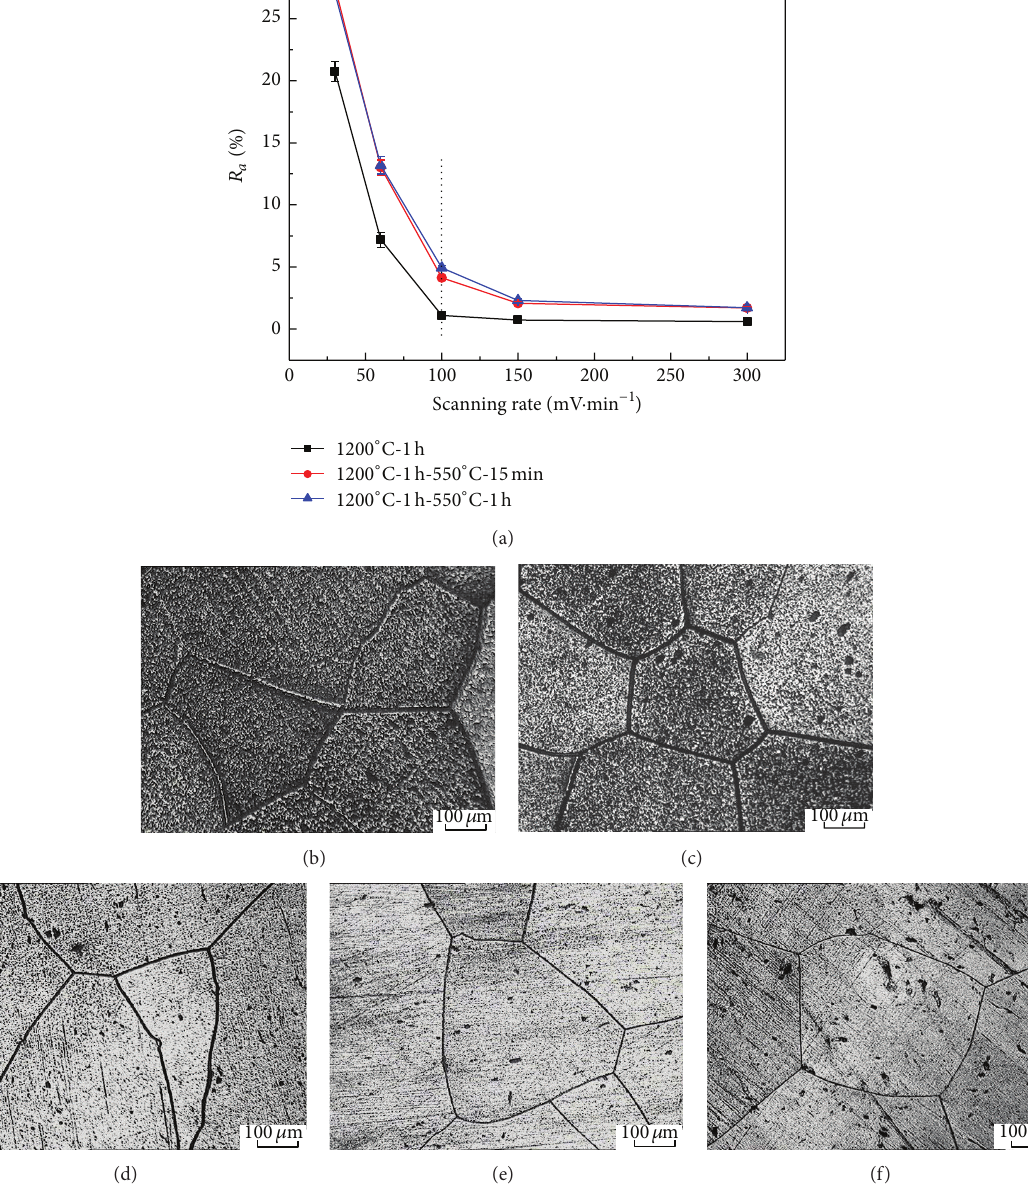
Figure 4: Effect of potential scanning rate in the DL-EPR test. (a) Influence on 𝑅 𝑎 values (0.5M H 2 SO 4 + 0.0001 M KSCN, 𝑇 = 30 ∘ C); (b)–(f) micrographs of FSS 429 aging at 550 ∘ C for 1h after test, (b) 30 mV/min, (c) 60 mV/min, (d) 100 mV/min, (e) 150mV/min, and (f) 300